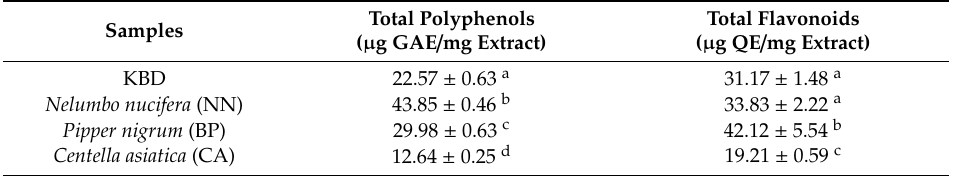
Table 1. Total phenolic and flavonoid contents in the Kleeb Bua Daeng formula (KBD) and its components. The total phenolic and flavonoid contents of each extract are shown as µ g of gallic acid equivalents per mg of extract ( µ g GAE / mg Extract) and as µ g of quercetin equivalents per mg of extract ( µ g QE / mg Extract), respectively. Data are represented as mean ± SD ( n = 3). Di ff erent letters in the same column are significantly di ff erent ( p < 0.05).